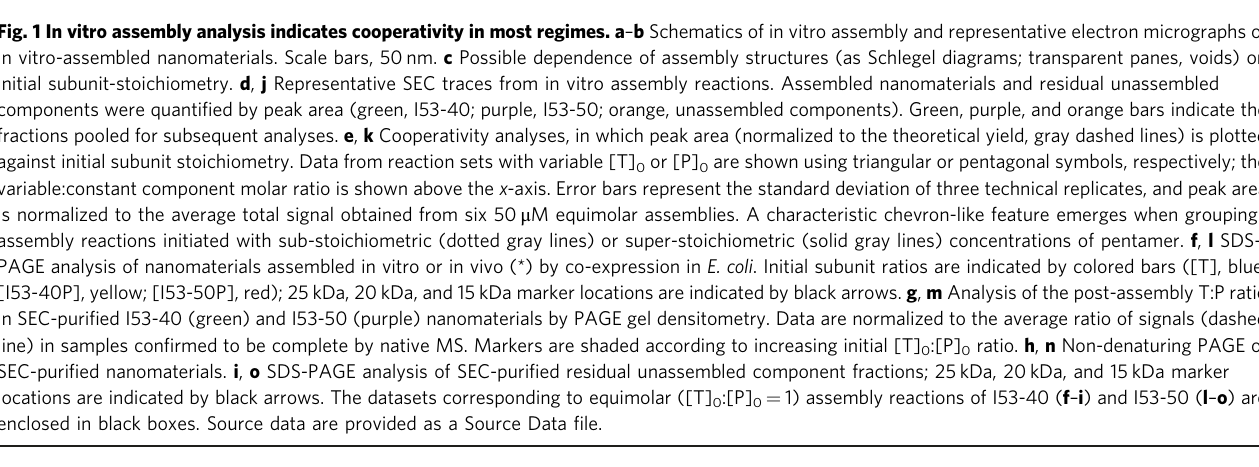
Fig. 1 In vitro assembly analysis indicates cooperativity in most regimes. a – b Schematics of in vitro assembly and representative electron micrographs of in vitro-assembled nanomaterials. Scale bars, 50 nm. c Possible dependence of assembly structures (as Schlegel diagrams; transparent panes, voids) on initial subunit-stoichiometry. d , j Representative SEC traces from in vitro assembly reactions. Assembled nanomaterials and residual unassembled components were quanti fi ed by peak area (green, I53-40; purple, I53-50; orange, unassembled components). Green, purple, and orange bars indicate the fractions pooled for subsequent analyses. e , k Cooperativity analyses, in which peak area (normalized to the theoretical yield, gray dashed lines) is plotted against initial subunit stoichiometry. Data from reaction sets with variable [T] 0 or [P] 0 are shown using triangular or pentagonal symbols, respectively; the variable:constant component molar ratio is shown above the x- axis. Error bars represent the standard deviation of three technical replicates, and peak area is normalized to the average total signal obtained from six 50 μ M equimolar assemblies. A characteristic chevron-like feature emerges when grouping assembly reactions initiated with sub-stoichiometric (dotted gray lines) or super-stoichiometric (solid gray lines) concentrations of pentamer. f , l SDS- PAGE analysis of nanomaterials assembled in vitro or in vivo (*) by co-expression in E. coli . Initial subunit ratios are indicated by colored bars ([T], blue; [I53-40P], yellow; [I53-50P], red); 25 kDa, 20 kDa, and 15 kDa marker locations are indicated by black arrows. g , m Analysis of the post-assembly T:P ratio in SEC-puri fi ed I53-40 (green) and I53-50 (purple) nanomaterials by PAGE gel densitometry. Data are normalized to the average ratio of signals (dashed line) in samples con fi rmed to be complete by native MS. Markers are shaded according to increasing initial [T] 0 :[P] 0 ratio. h , n Non-denaturing PAGE of SEC-puri fi ed nanomaterials. i , o SDS-PAGE analysis of SEC-puri fi ed residual unassembled component fractions; 25 kDa, 20 kDa, and 15 kDa marker locations are indicated by black arrows. The datasets corresponding to equimolar ([T] 0 :[P] 0 = 1) assembly reactions of I53-40 ( f – i ) and I53-50 ( l – o ) are enclosed in black boxes. Source data are provided as a Source Data fi